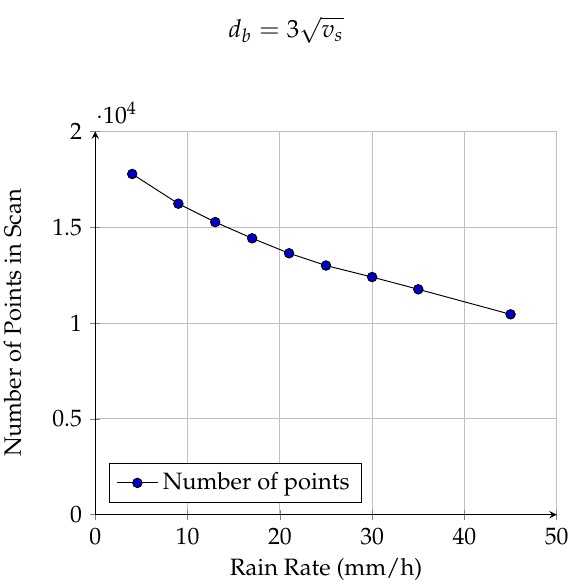
Figure 5. Number of points in a single scan of the LIDAR as a function of rain rate.